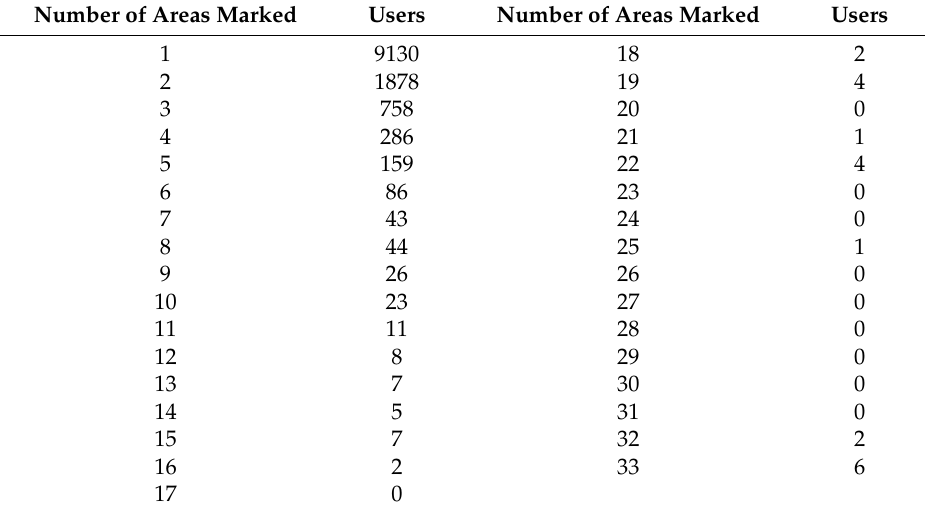
Table 6. Number of users according to the number of thematic areas selected in each download. Number of Areas Marked Users Number of Areas Marked Users 1 9130 18 2